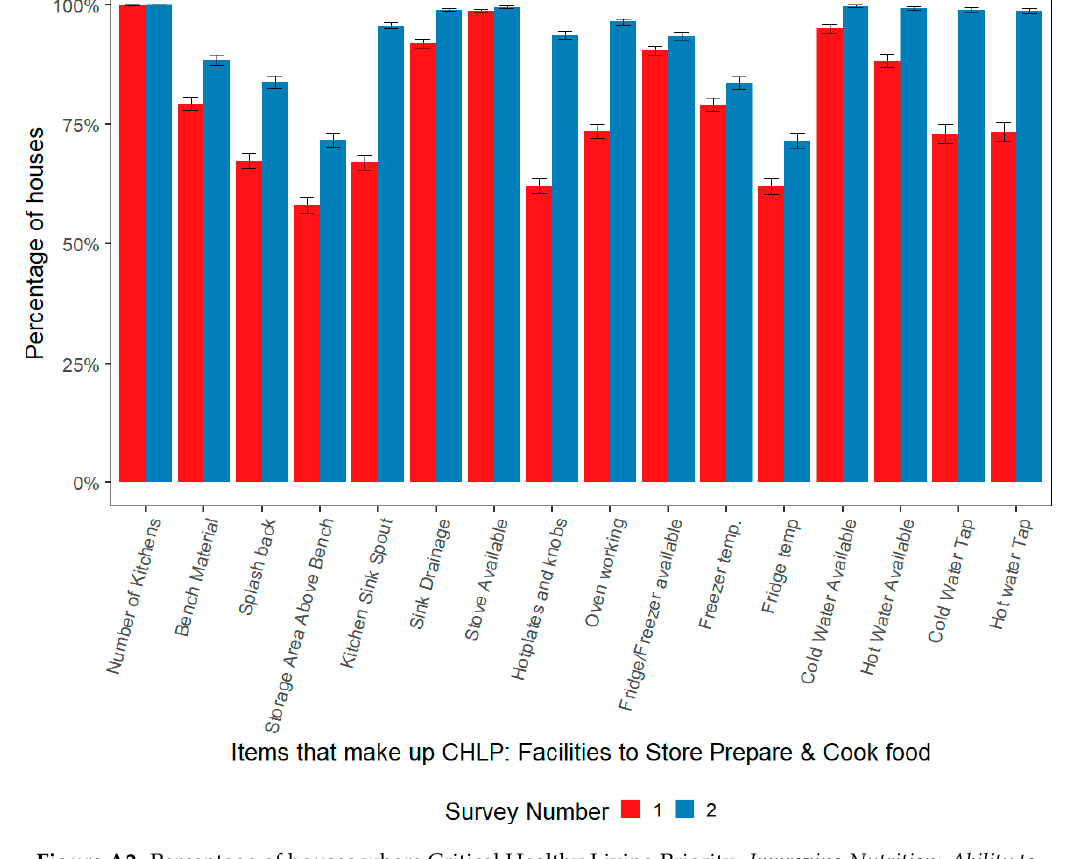
Figure A2. Percentage of houses where Critical Healthy Living Priority: Improving Nutrition: Ability to Store, Prepare and Cook Food was fully met for all NSW projects from 1998–2017.